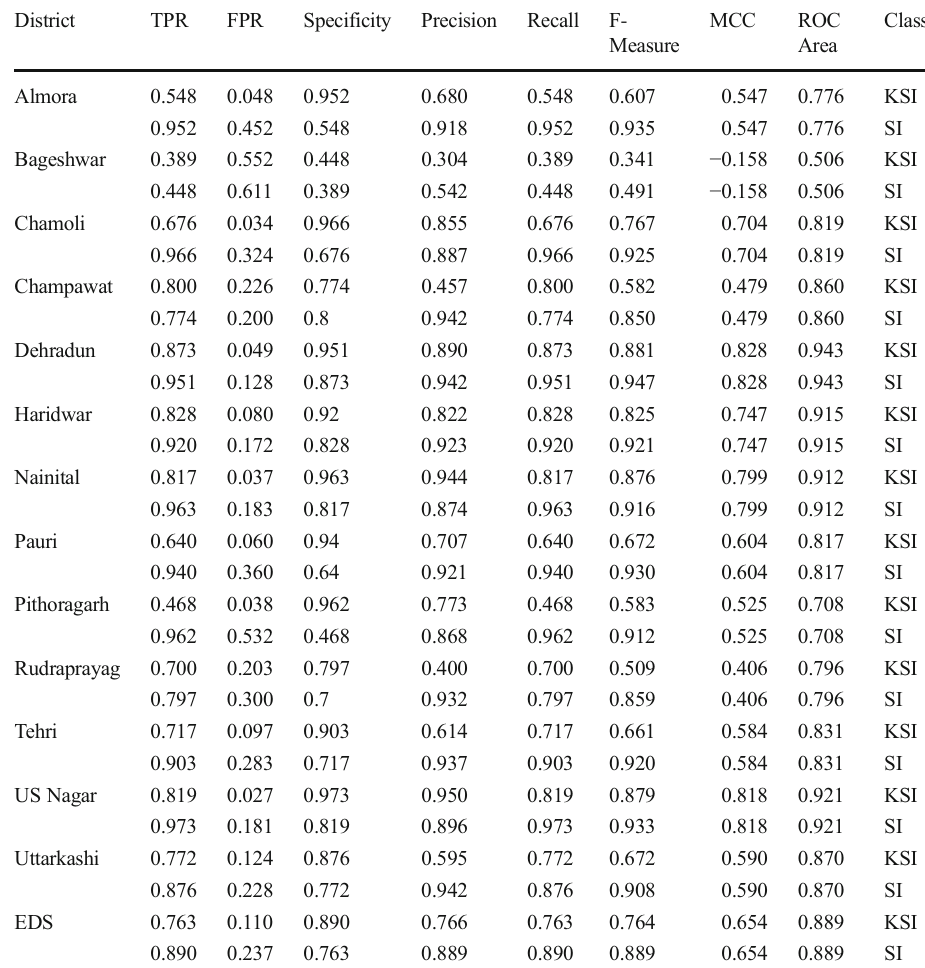
Table 5 CART performance metrics for 13 districts and